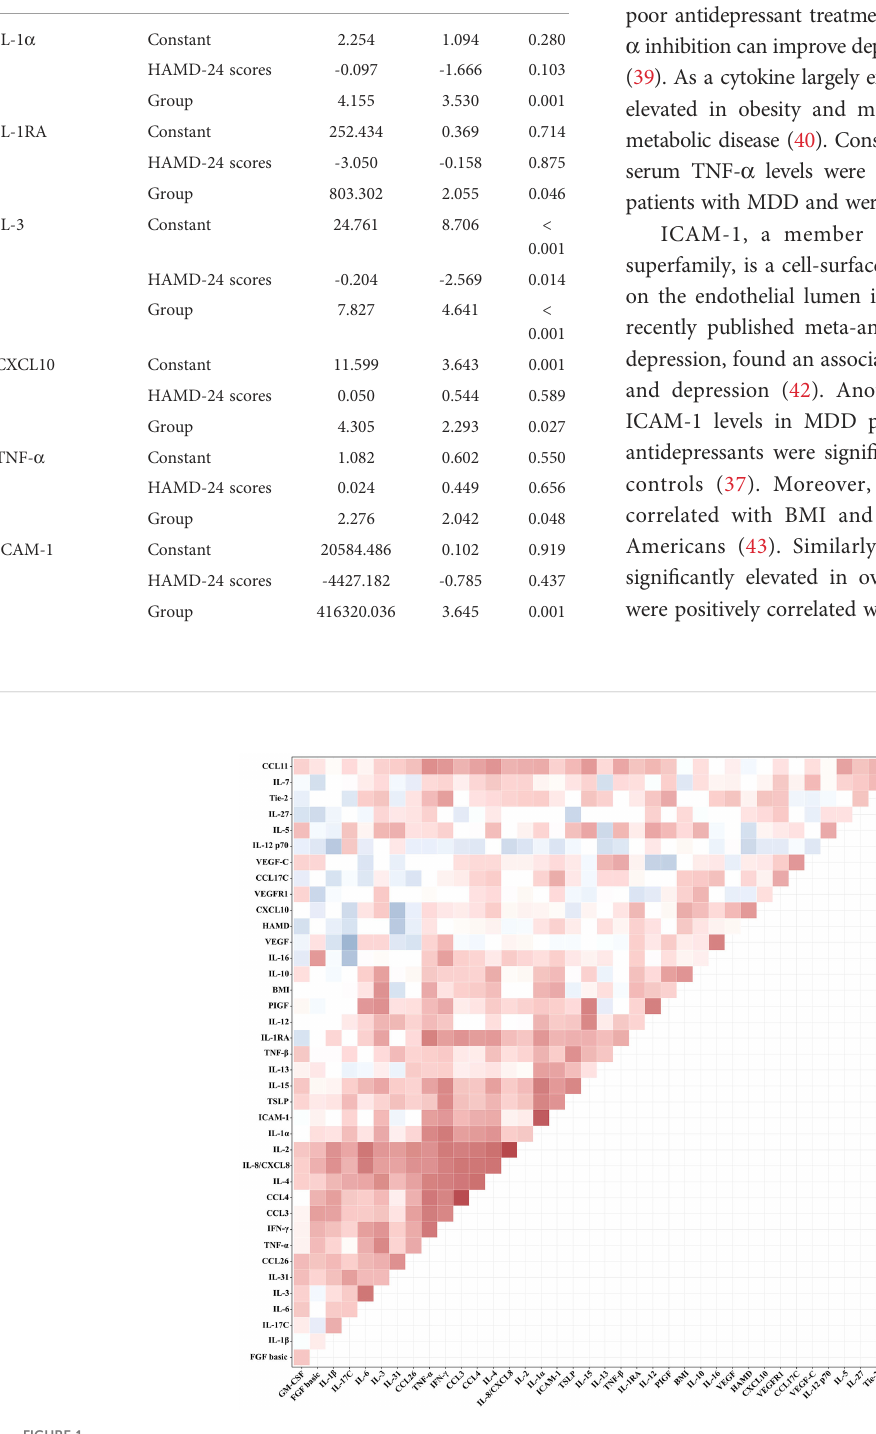
FIGURE 1 Correlation between BMI and HAMD-24 scores and the serum levels of cytokines in patients with MDD (Pearson correlation